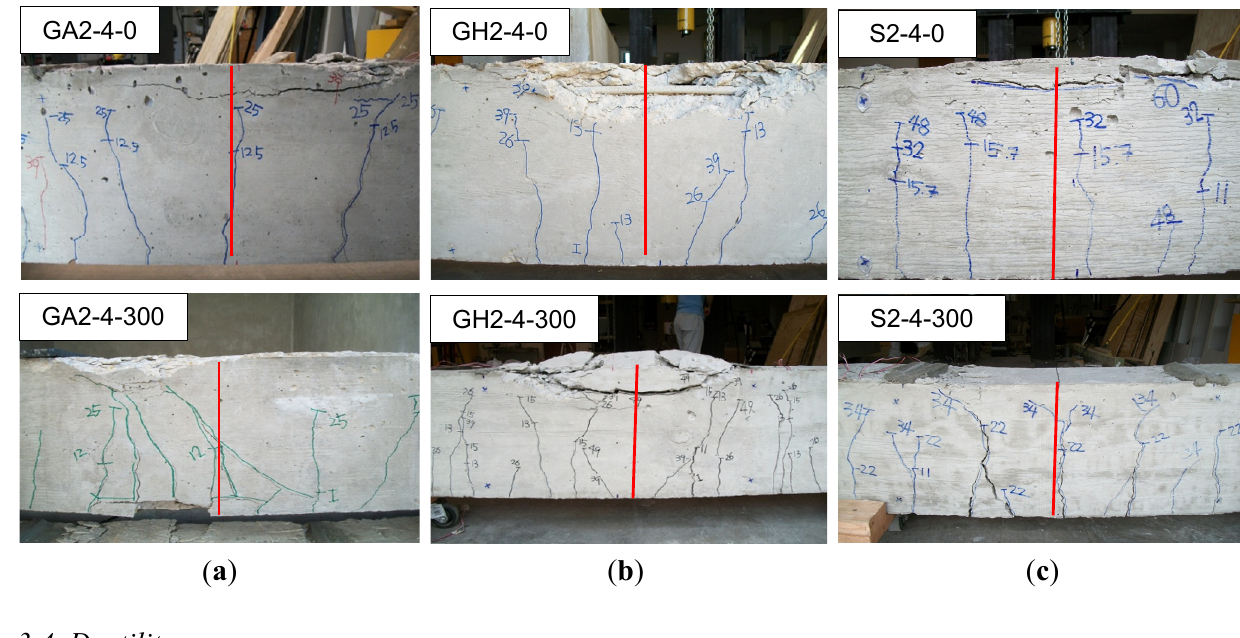
Figure 7. Crack pattern at the ultimate stage of the ( a ) GA2-4-0 and